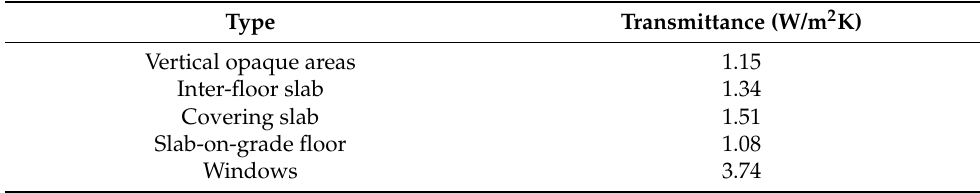
Table 3. Transmittance value of the building envelope.